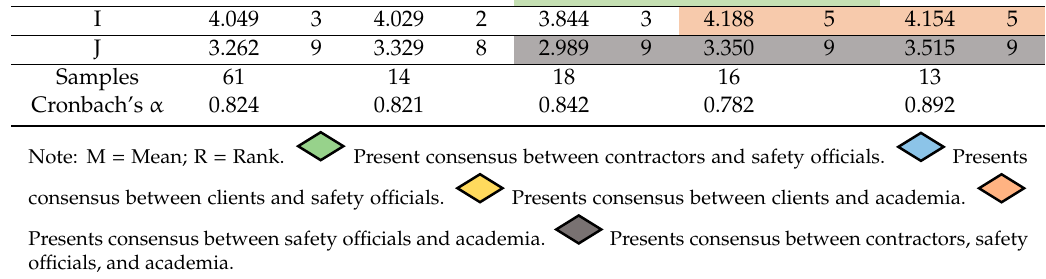
Table 4. First Round of Delphi Survey. Table 5. Second Round of Delphi Survey.